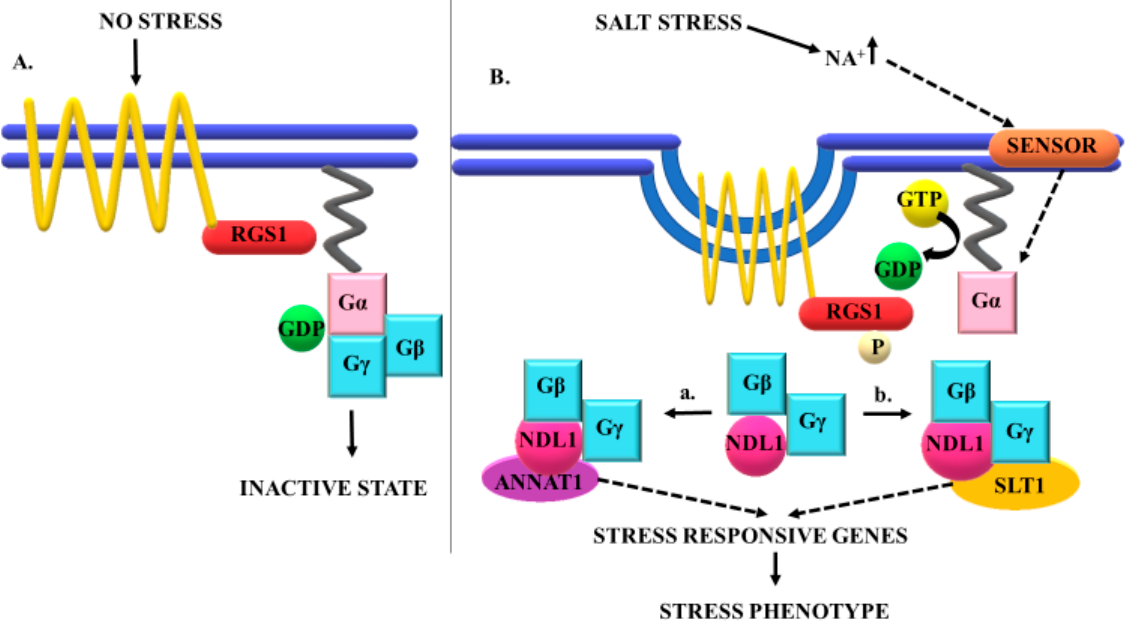
Figure 5. Proposed working model for G-protein meditated salt stress tolerance via NDL1; ( A ) no stress condition, ionic balance is maintained, G-protein is at inactive state. ( B ) Salt stress leads to activation of G-protein signaling, internalization of RGS1 takes place, exchange of GDP to GTP leads to activation of G α subunit, followed by dissociation of G βγ dimer. NDL1 interacts with G βγ dimer and along with its putative interactors (a-ANNEXIN) or (b-SLT1) directly or indirectly leads to the activation of salt responsive genes and finally salt stress response.